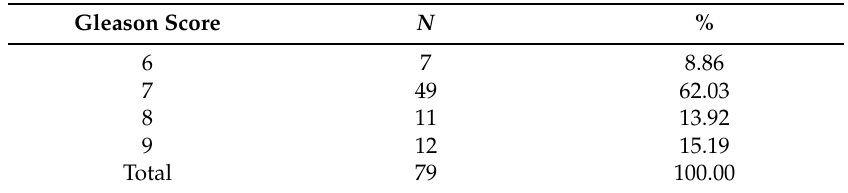
Table 3. Frequency of important clinical parameters for the study cohort. Gleason Score.